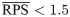
Time-averaged (over months 52-72 for comparability) RPS for three- (A) and four-month-ahead (B) predictions versus one-month-ahead.Scores are closely matched for the majority of blocks (where RPS¯<1.5) but the differences increase for blocks which are harder to predict.